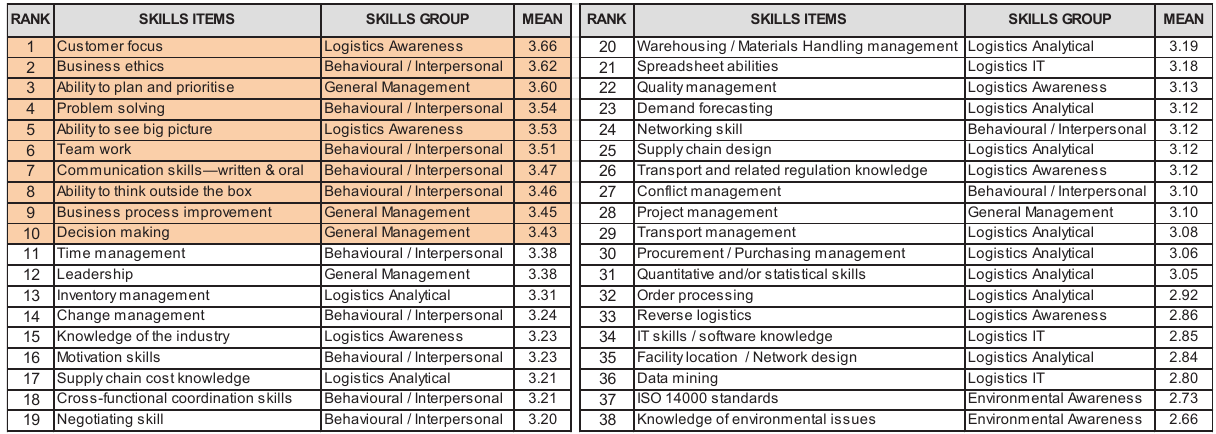
Figure 4: Ranking of skills per skills group